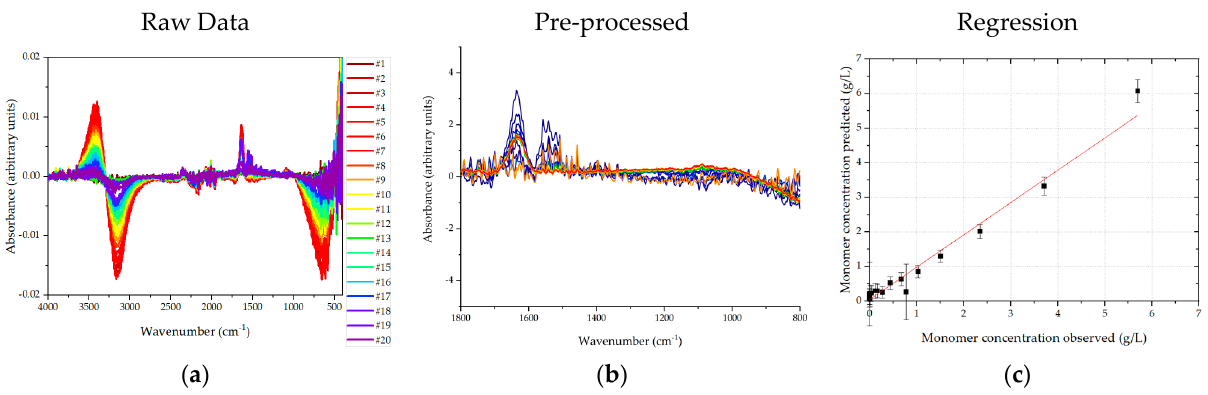
Figure 8. Data of FTIR spectra ( a ), pre-processed spectra ( b ) and PLS results ( c ). Spectra are color-coded from high concentration (blue) to low concentration (red).